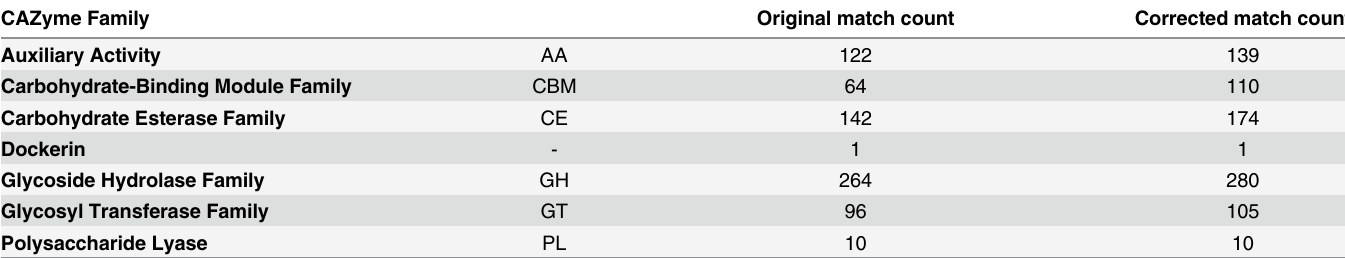
Table 4. Summary of carbohydrate-active enzyme (CAZyme) family numbers in P . nodorum SN15 before and after manual